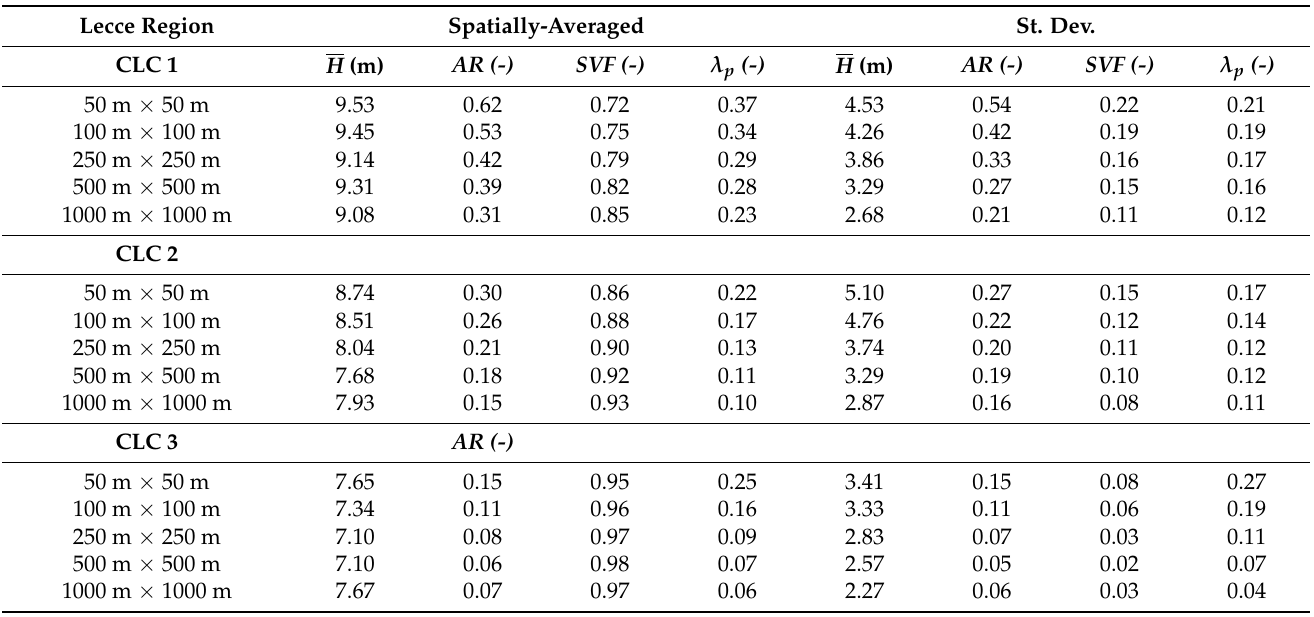
Table 5. Spatially-averaged values and standard deviations of the morphological parameters for the three CLCs for the Lecce region using different grid